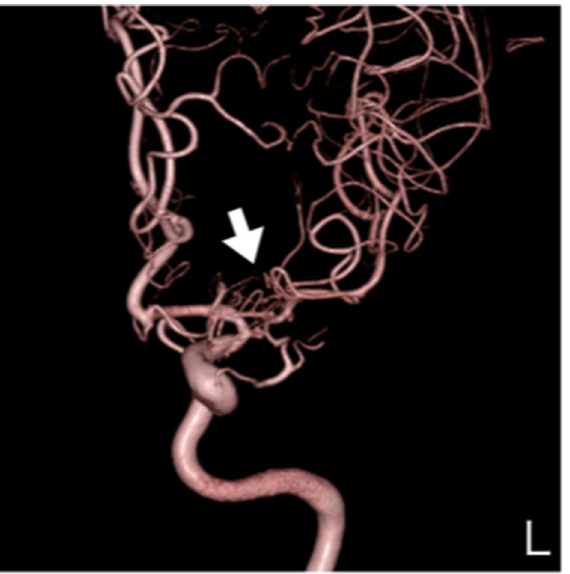
Figure 8. Anterior posterior view of three-dimensional digital subtraction left internal carotid angiographical findings in patient 8 indicating left twig-like middle cerebral artery (white arrow). The moyamoya vessels were not present.